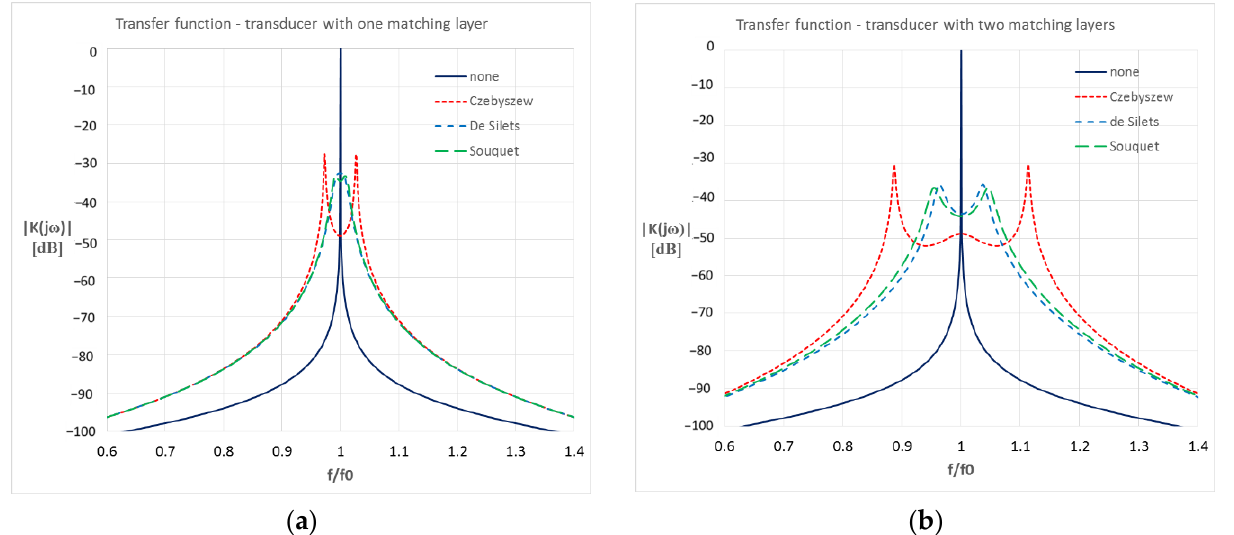
Figure 2. Transfer functions for a transducer operated in air: ( a ) with one matching layer, ( b ) with two matching layers.